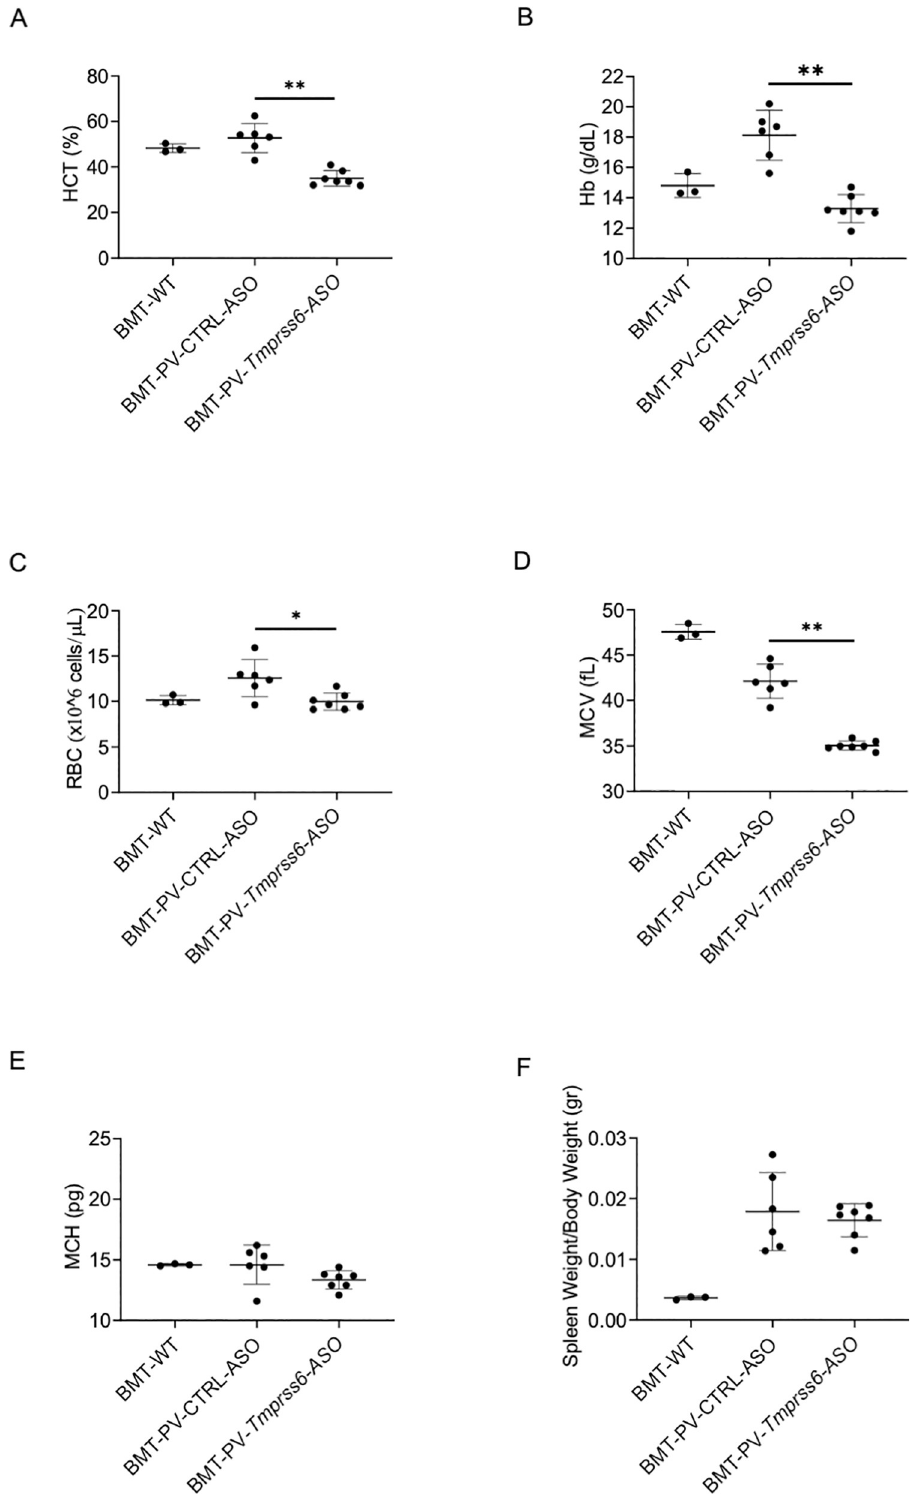
Fig 1. Normalization of the hematological panel of PV animals following Tmprss6 -ASO treatment. One month after bone marrow transplant (BMT) animals received Tmprss6 -ASO or CTRL-ASO. Six weeks of Tmprss6- ASO administration led to the significant reduction in HCT (A) as well as Hb (B) , and RBC (C) when compared with